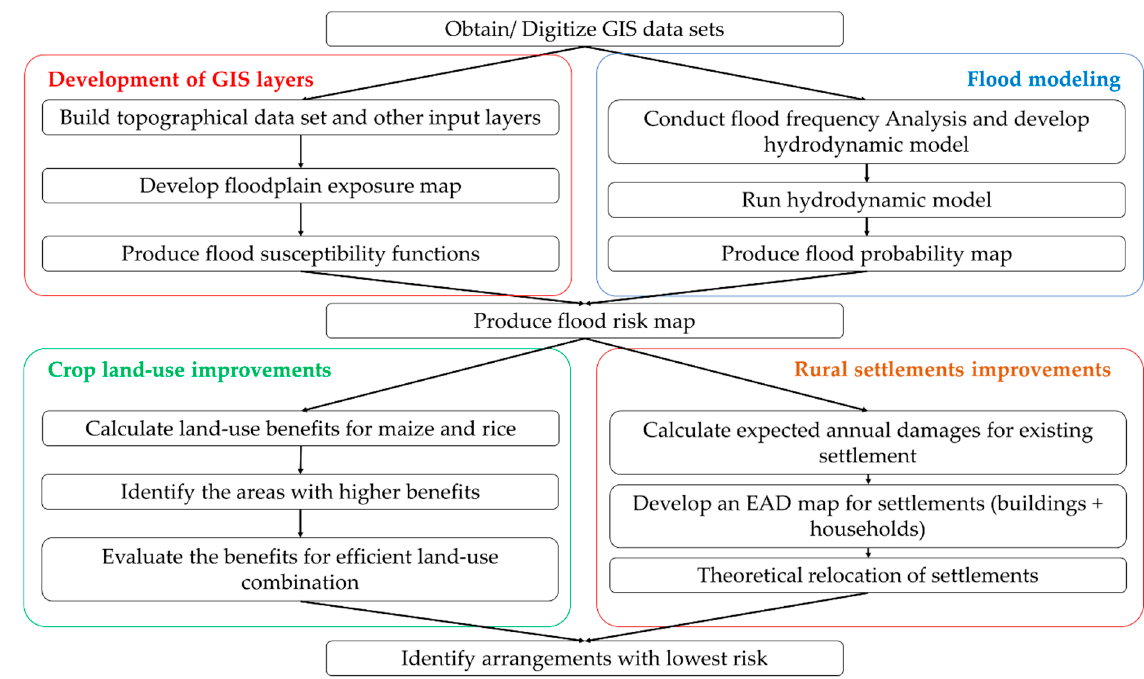
Figure 7. An elaborated step-by-step procedure for the agriculture and settlements land-use method derived from Figure 5.